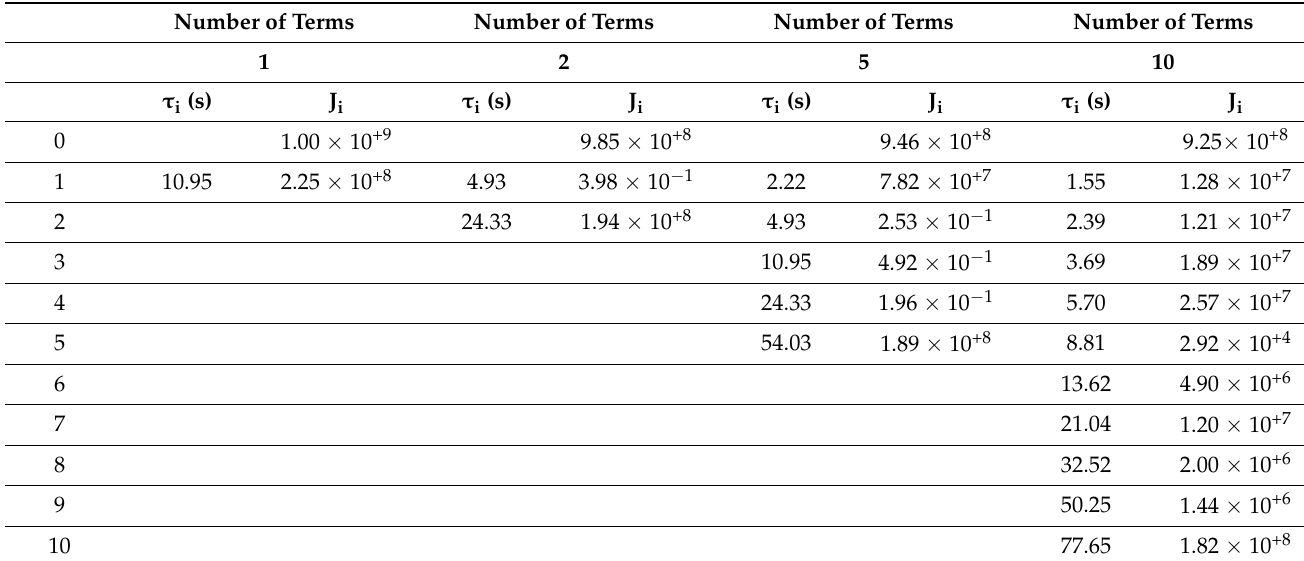
Table 3. Prony series for ABS material and layer printing d = 0.19 mm.